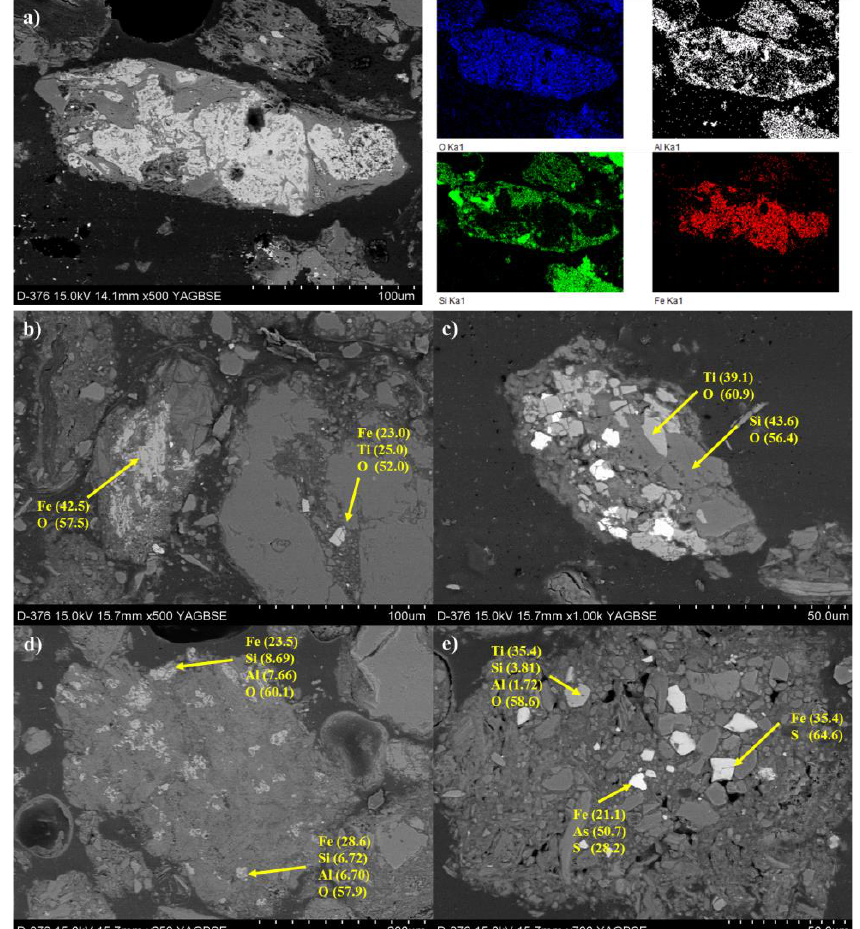
Figure 7. Scanning electron micrographs in backscattered electrons (BSE) of polished sample. ( a ) Scanning electron micrographs in backscattered electrons (BSE) and EDS mapping. ( b – e ) Back-scattered electron (BSE) image and EDS spot analysis. Element concentrations are expressed in wt%.